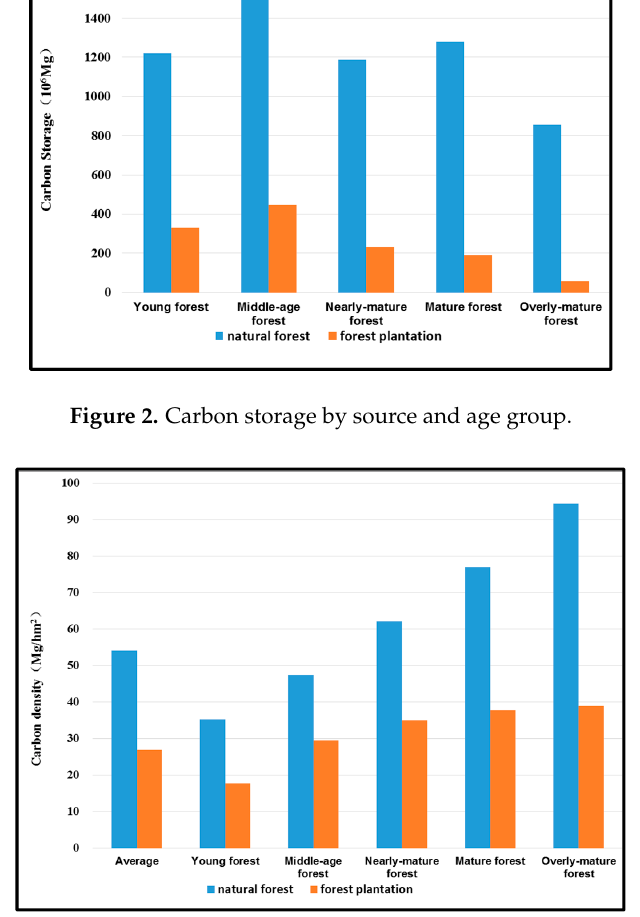
Figure 3. Carbon density by source and age group.